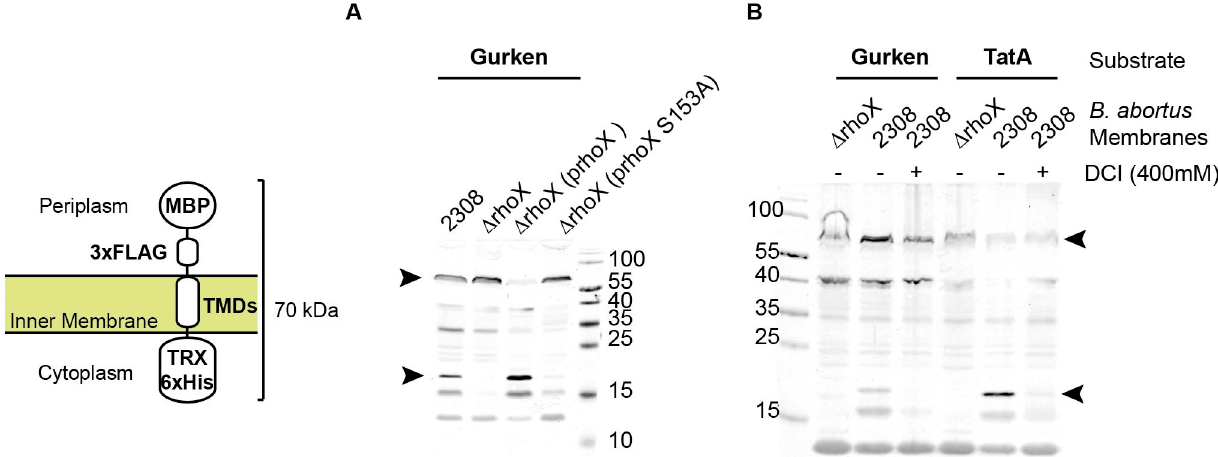
Figure 3. B. abortus membrane-associated rhomboid protease activity. ( A ) Cleavage of Gurken chimeric substrate by B. abortus solubilized membrane fractions of the indicated strains. Cell extracts of E. coli MG1655 ∆ glpEGR::kan transformed with the plasmid for the expression of Gurken chimeric protein were incubated with the solubilized membranes. After incubation, samples were TCA-precipitated and used in SDS-PAGE and Western blot experiments with anti-His antibody. ( B ) Cleavage of Gurken and TatA chimeric substrates by B. abortus solubilized membrane fractions of the indicated strains in the presence or absence of 3,4-DCI inhibitor. Cell extracts of E. coli MG1655 ∆ glpEGR::kan transformed with plasmids for the expression of Gurken or TatA chimeric protein were incubated with the solubilized membranes. After incubation, samples were TCA-precipitated and used in SDS-PAGE and Western blot with anti-His antibody. The bands corresponding to un- processed and processed substrates are pointed out by arrow heads. Migration of molecular mass markers (kDa) is indicated in each blot. On the left, a schematic representation of the chimeric protein substrates is shown. 2308: wild type; ∆ rhoX : rhomboid deletion mutant; ∆ rhoX + p rhoX : rhomboid deletion mutant complemented with wild type rhomboid; ∆ rhoX + p rhoX S153A: rhomboid deletion mutant complemented with rhomboid mutant